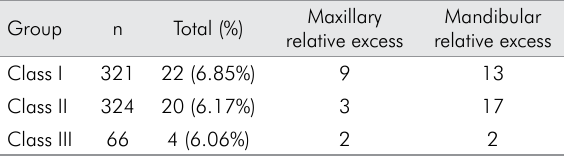
Table 5. Frequency of patients presenting overall Bolton discrepancy greater or smaller than 2 SD (< 87.48 or > 95.12).